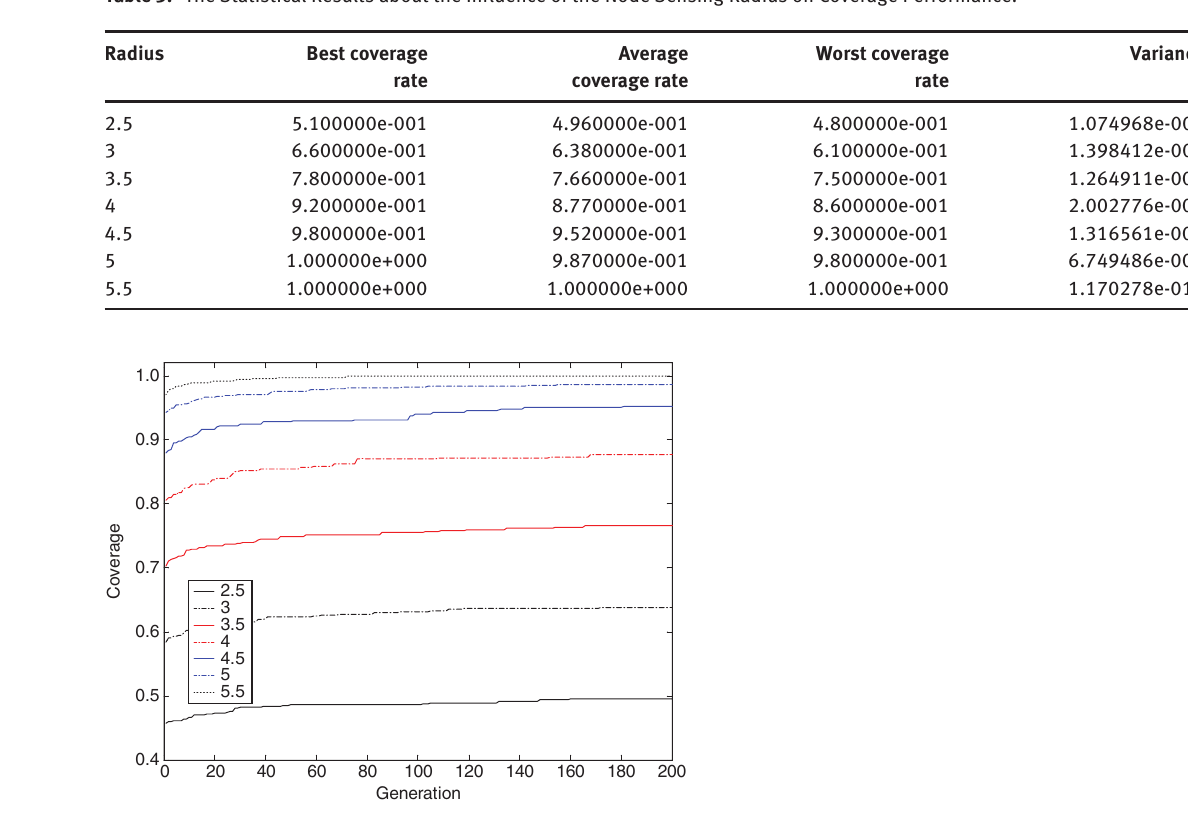
Table 3: The Statistical Results about the Influence of the Node Sensing Radius on Coverage